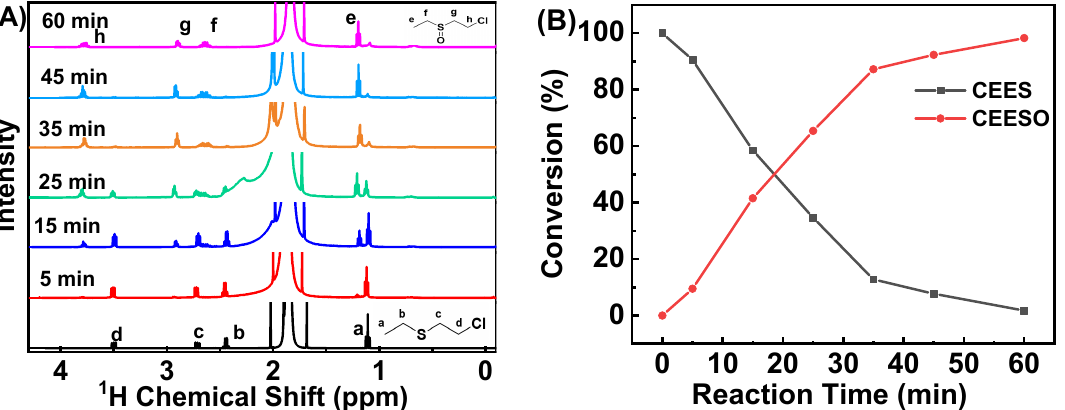
Figure 7. Catalytic oxidation of CEES by HCCP-V:H 2 O 2 = 1:1.2 at room temperature: ( A ) 1 H NMR spectra of the catalytic oxidation process (CDCl 3 ). ( B ) The conversion curves of CEES and CEESO.